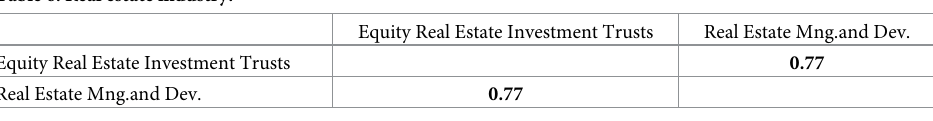
Table 6. Real estate industry.